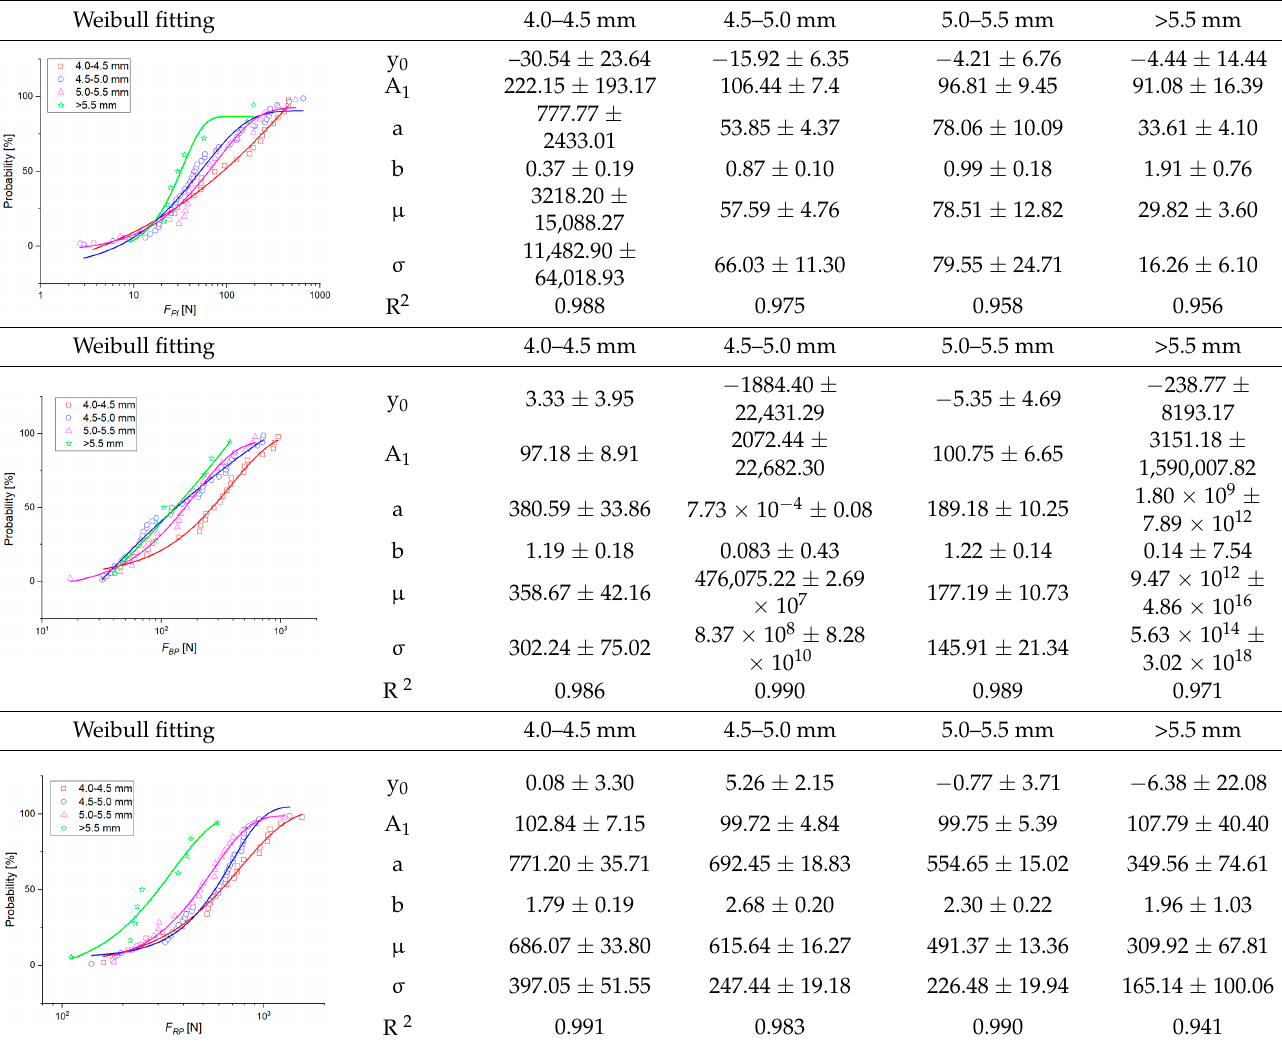
Table 3. Cumulated distributions of probability of the occurrence of forces, energy, and stresses while compressing corn Table A3. Cumulated distributions of probability of the occurrence of forces, energy, and stresses while compressing corn grains and their parameters. Table A3. Cumulated distributions of probability of the occurrence of forces, energy, and stresses while compressing corn grains and their parameters. grains and their parameters. Weibull fitting Table A3. Cumulated distributions of probability of the occurrence of forces, energy, and stresses while compressing corn grains and their parameters. Weibull